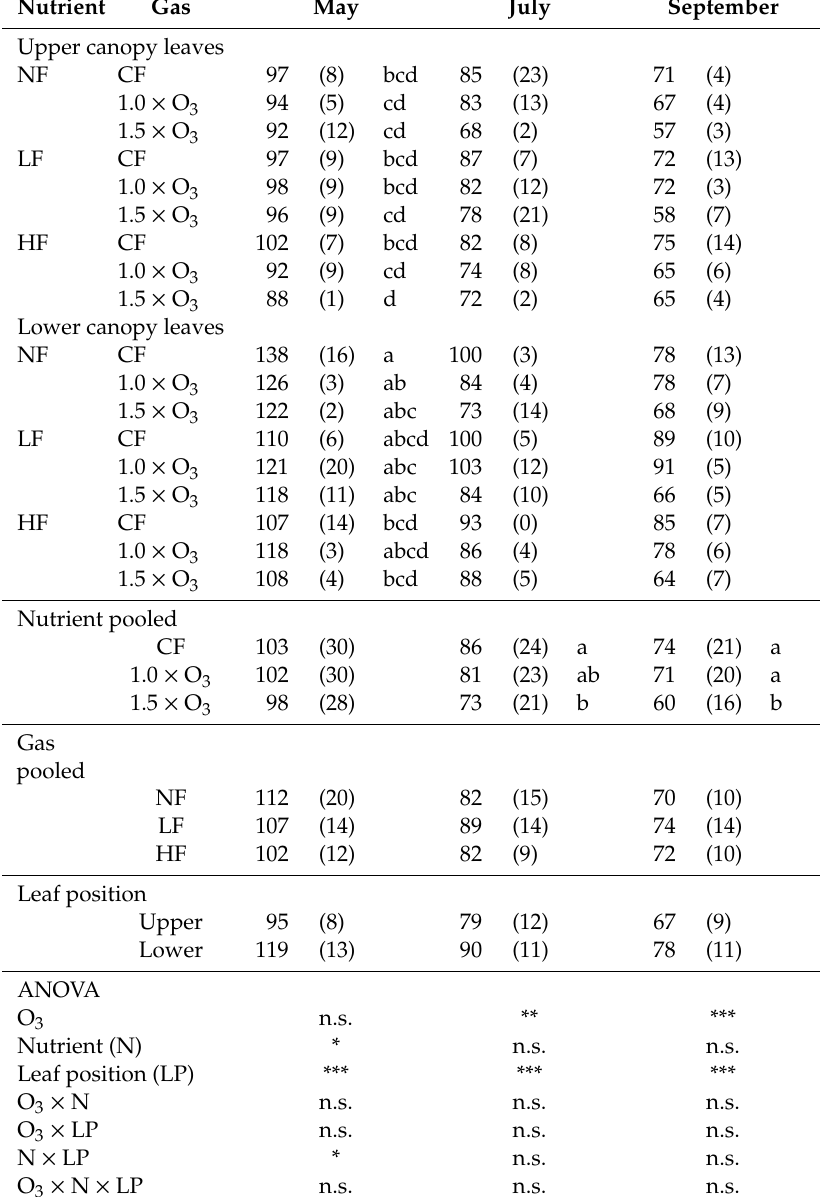
Table 5. Photosynthetic nitrogen use e ffi ciency ( µ mol mol − 1 s − 1 ) in upper and lower canopy leaves of Siebold’s beech